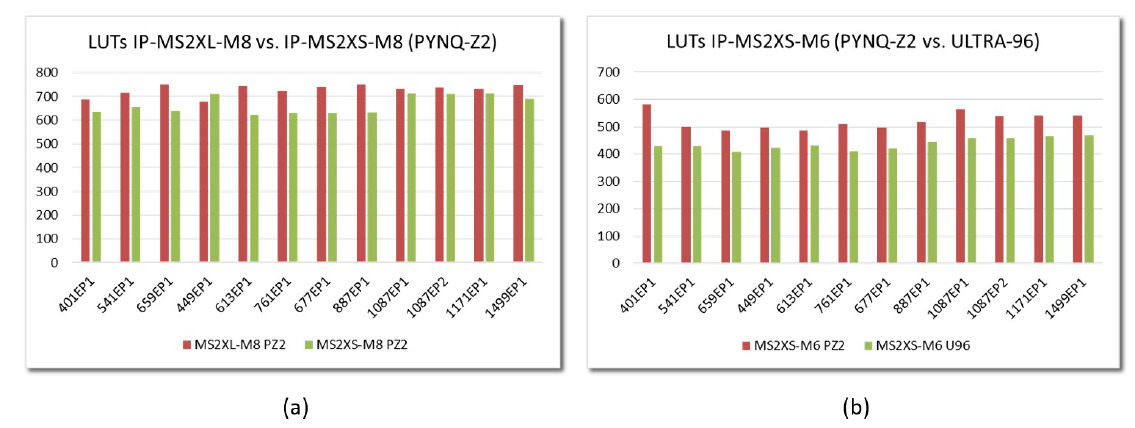
Figure 14. Comparison of LUTs required to implement the different IEEE Std 1363.1 parameter sets for ( a ) MS2XL and MS2XS IPs with M = 8 on Zynq-7000 devices; and ( b ) MS2XS IPs with M = 6 on Zynq-7000 and Zynq UltraScale+